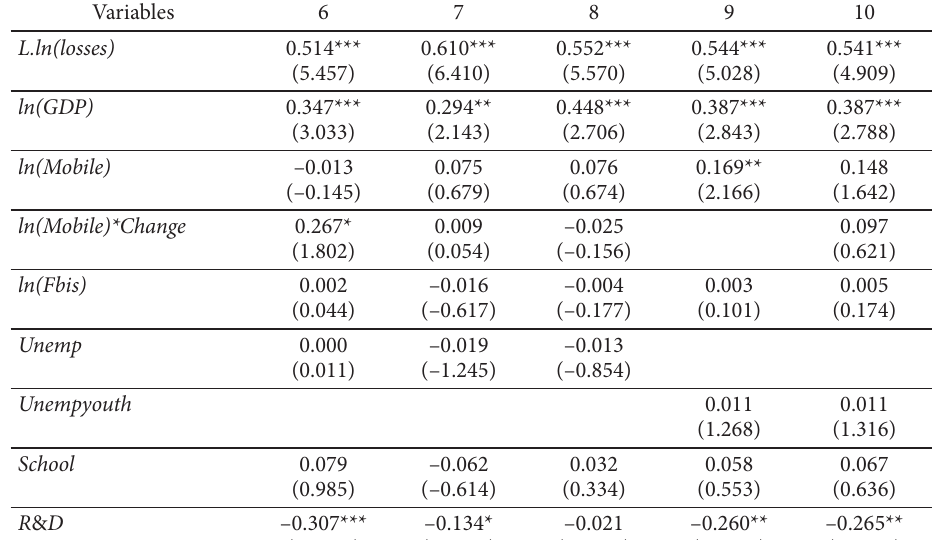
Table 3. Dynamic model using one-step System GMM